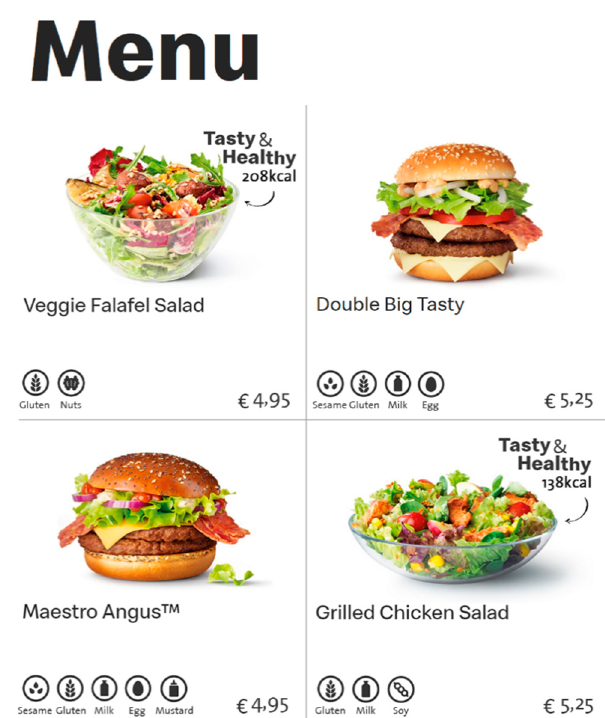
Figure 2. Condition 2: Explicit health information provided for a healthy menu product.